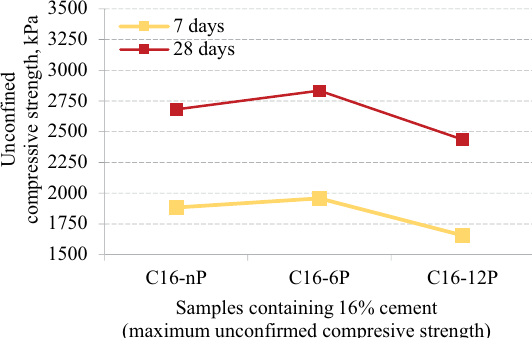
Figure 6. The unconfined compressive strength of samples stabilised using 16% OPC for different PP